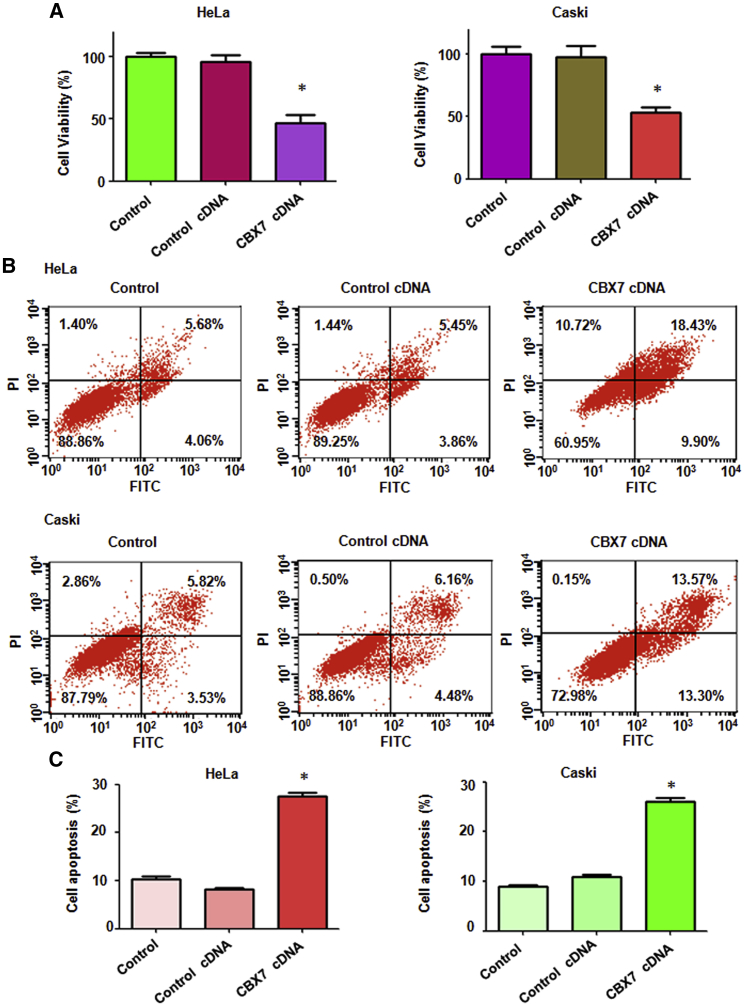
Overexpression of CBX7 Inhibits Cell Proliferation and Induces Apoptosis(A) Cell viability was measured by MTT in both HeLa and Caski cells with CBX7 construct transfection at 72 h. *p < 0.05 versus control group. (B) Cell apoptosis was determined by flow cytometry in cervical cancer cells with CBX7 construct transfection at 72 h. (C) Quantitative results are illustrated for cell apoptosis.